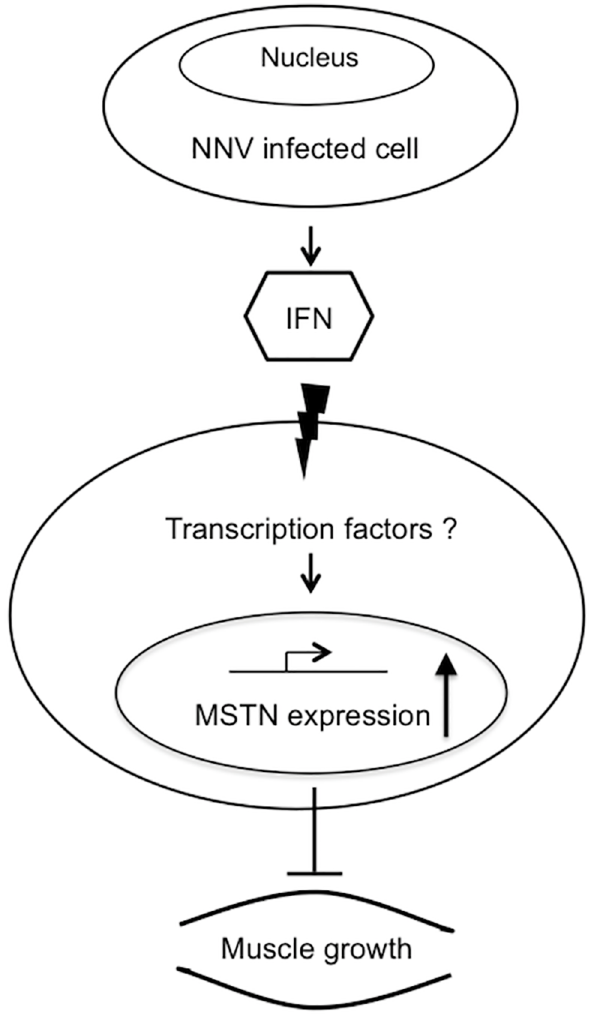
Fig 6. Simplified representation of the immune response to viral infection downregulates muscle growth. Infection of nervousnecrosis virus (NNV) triggeredantiviral response, which activated the interferon (IFN) pathway. The immune response of NNV infectionupregulatedmyostatin (MSTN) promoter activity.